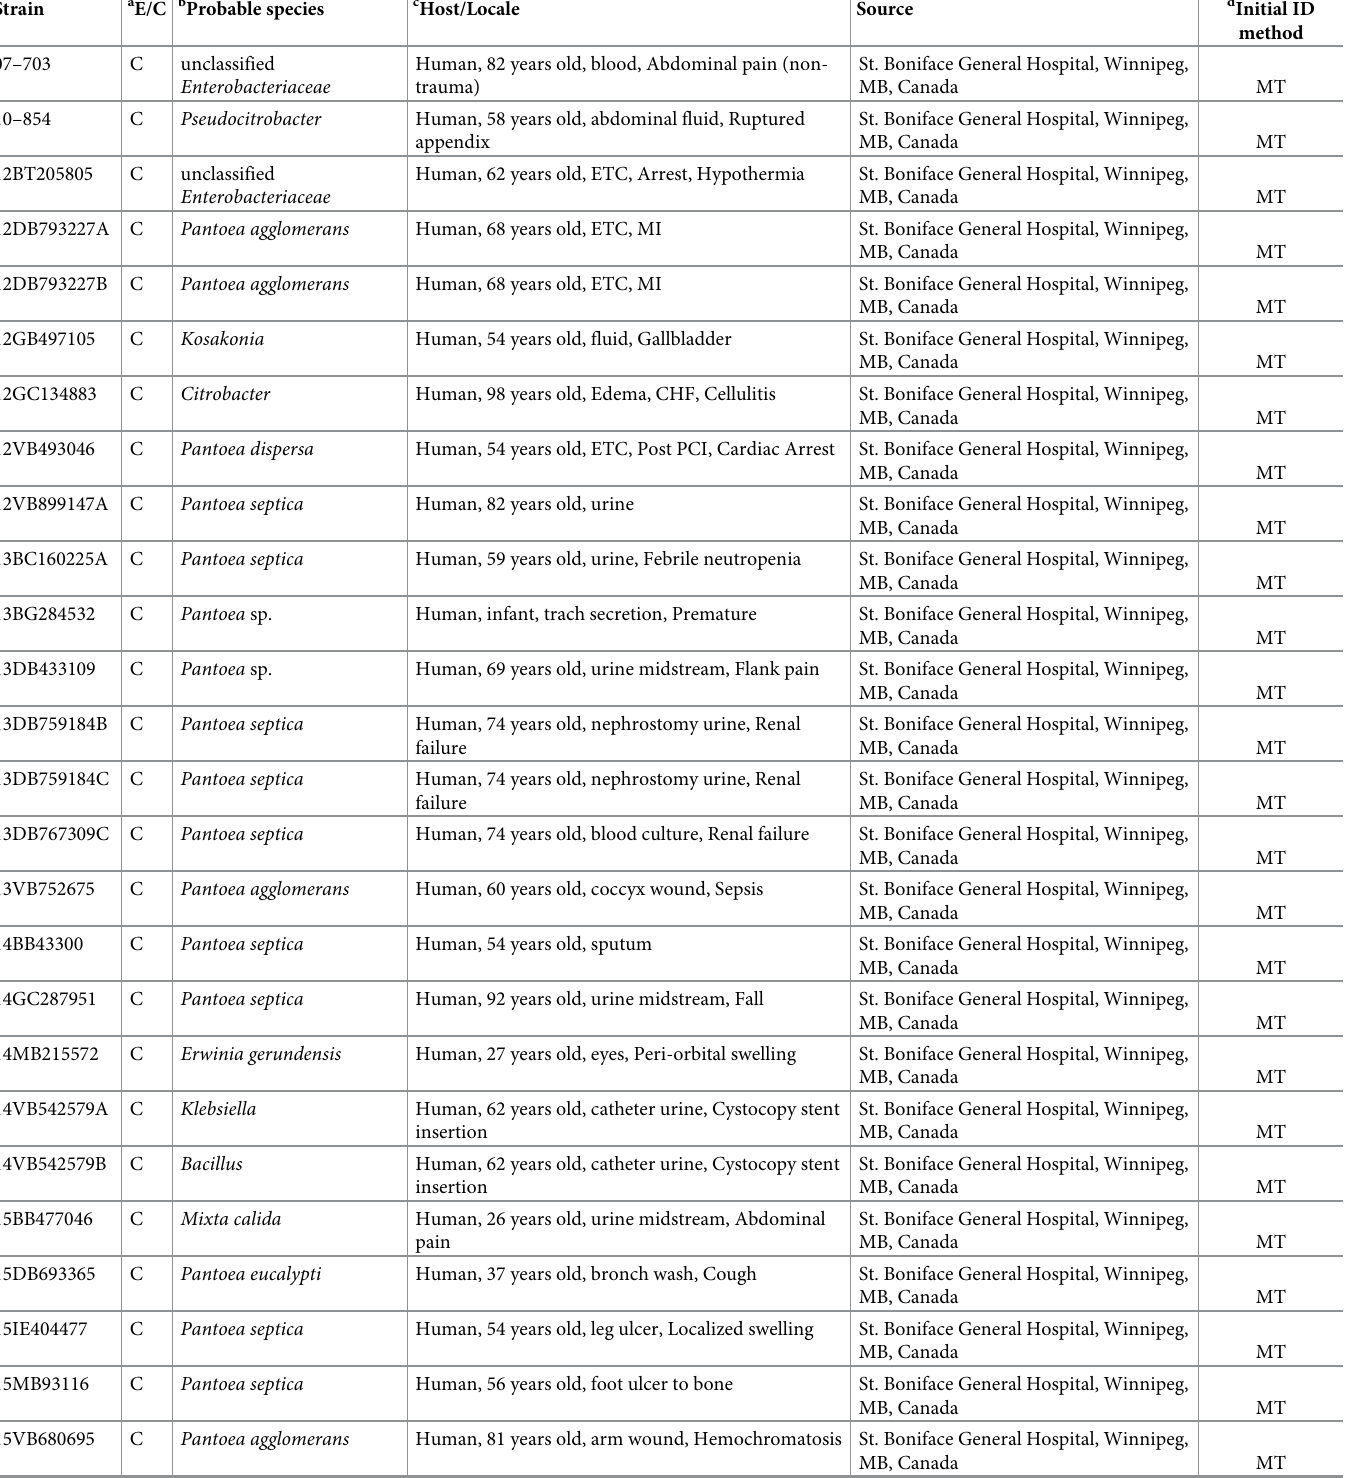
Table 1. Candidate Pantoea isolates used in this